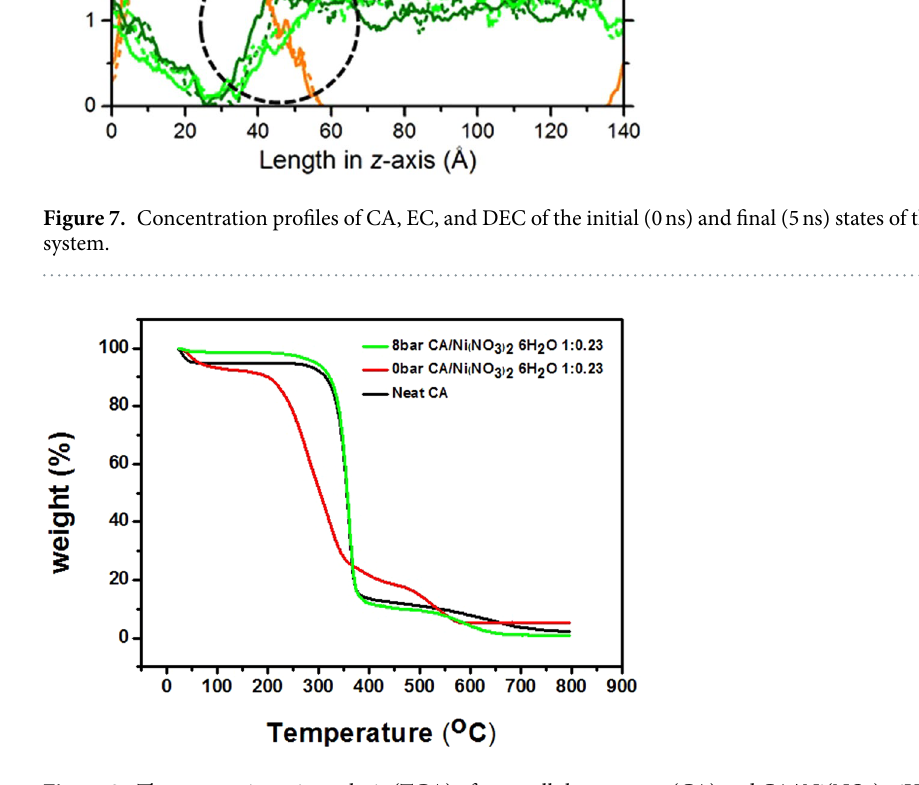
Figure 8. Thermogravimetric analysis (TGA) of neat cellulose acetate (CA) and CA/ Ni(NO 3 ) 2 ·6H 2 O polymer matrix at water pressures of 0 bar and 8